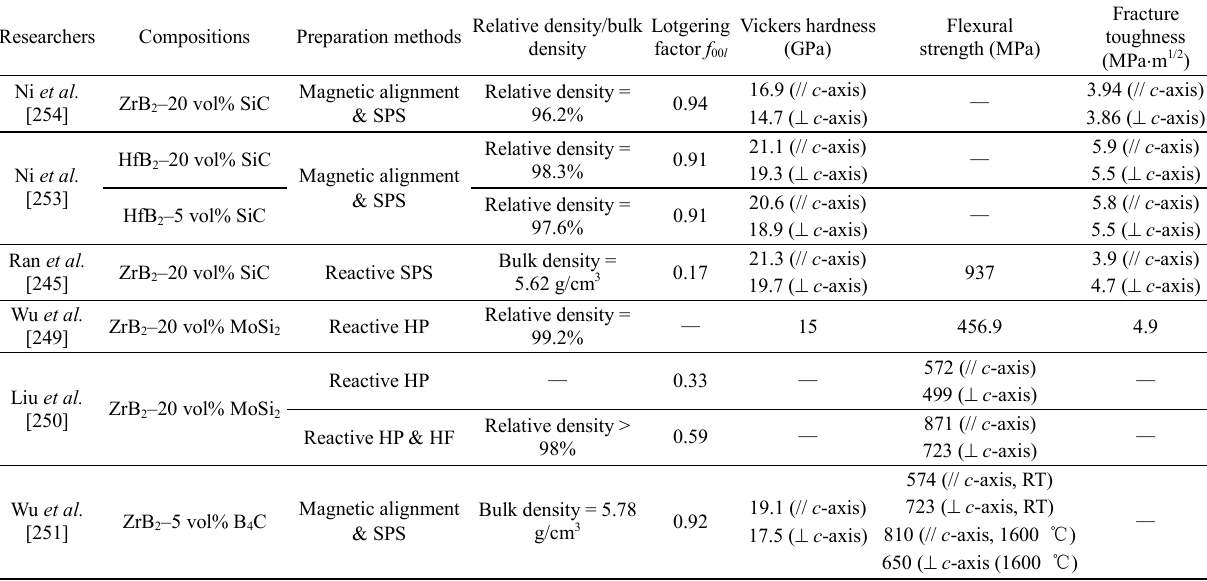
Table 9 Properties of textured MB2 matrix